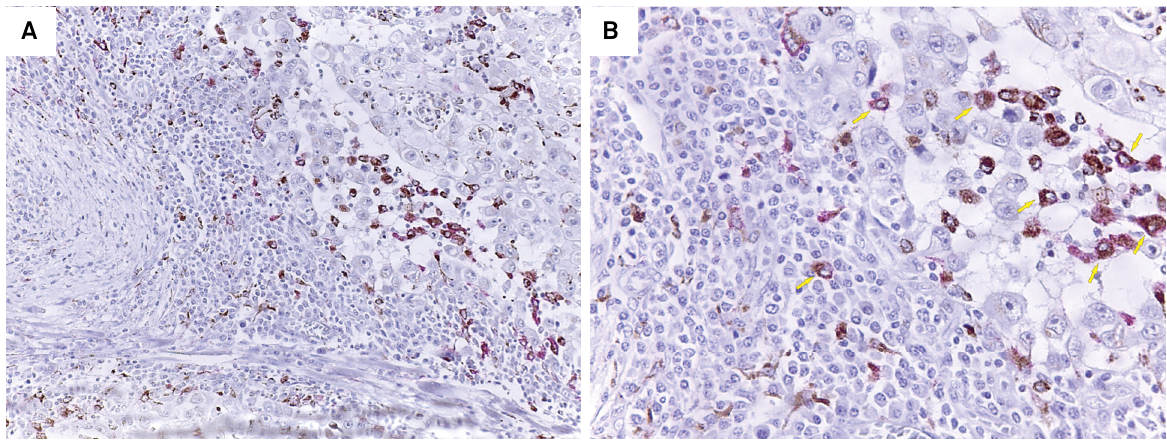
Figure 2. (A) Invasive front of SCCLL exhibiting CD68+ (brown staining) and CD163+ (red staining) cells (EnVision, 200×). (B) M2 TAMs (arrows) double stained with anti-CD68 and anti-CD163 antibodies (EnVision, 400×).